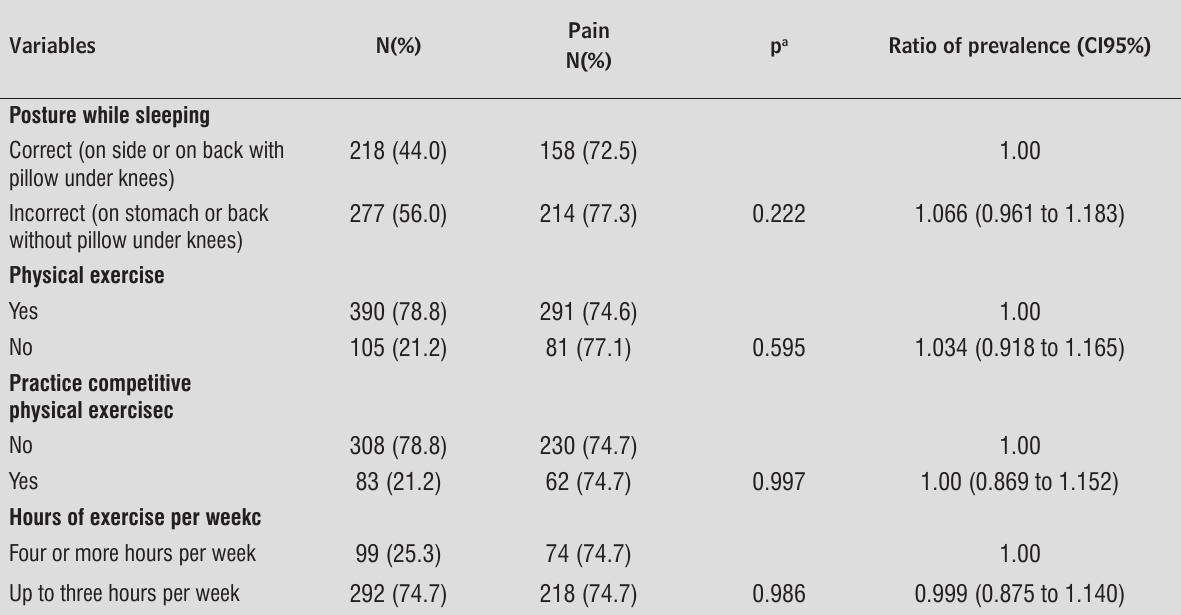
Table 2 - Prevalence of back pain and socioeconomic, demographic and anthropometric variables in female students aged 14 to 18 years, São Leopoldo, Rio Grande do Sul, Brazil, 2004